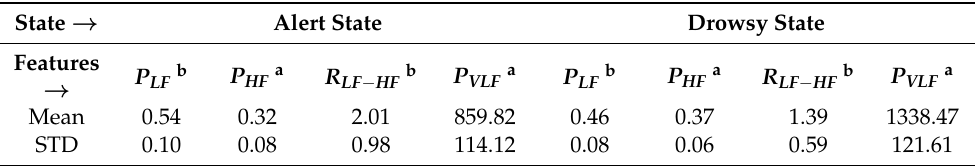
Table 3. HRV features of each subject in alert and drowsy